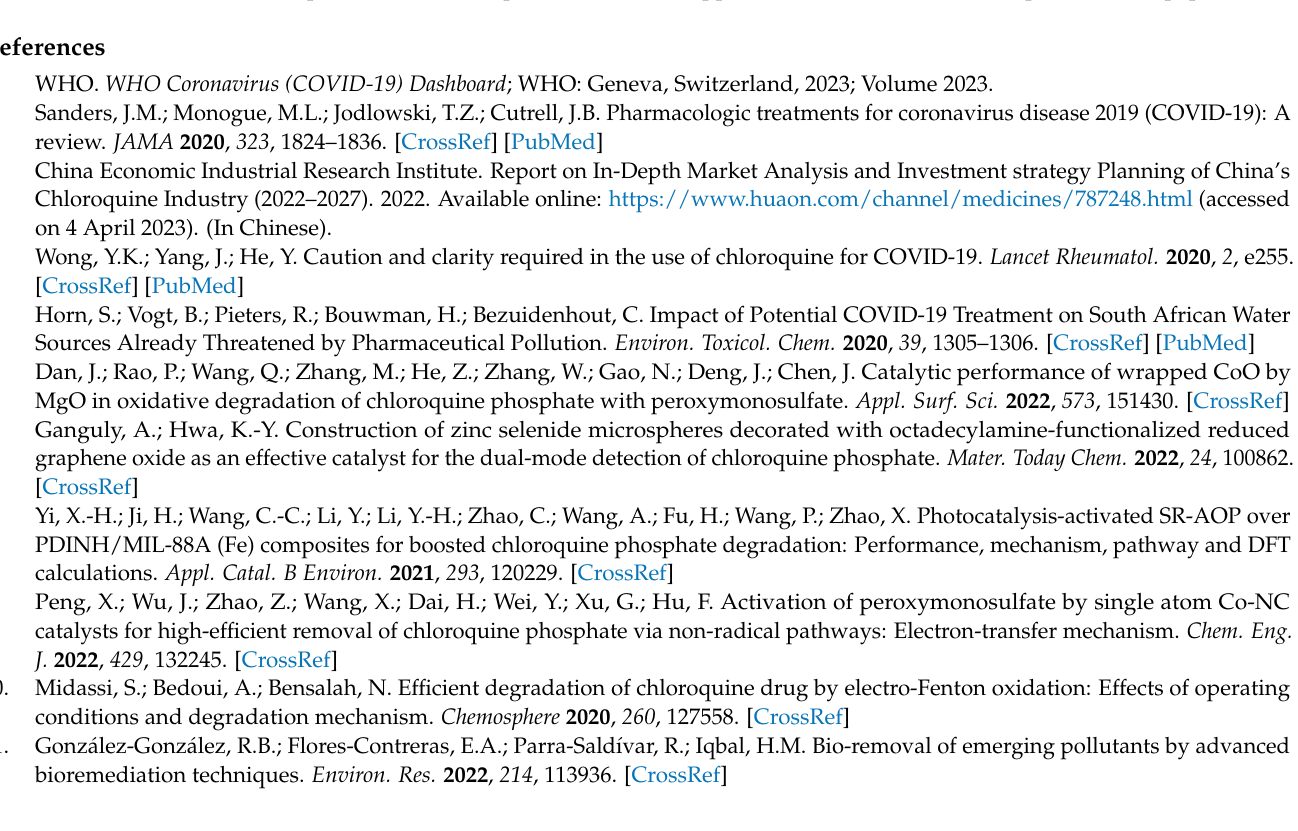
Table S2: Parameters of isotherm models for CQP adsorption on RSB and